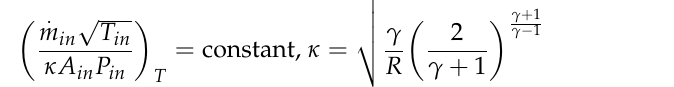
Figure 5. Control curve of the GT.